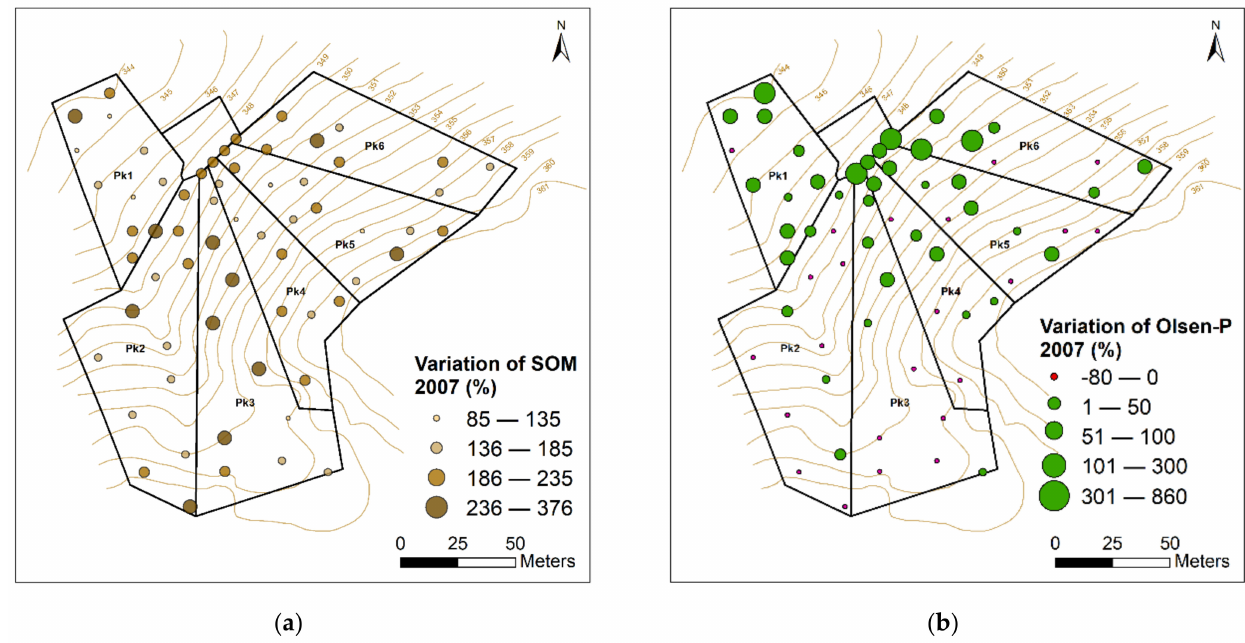
Figure 5. Spatial distribution of the variation (%) of ( a ) SOM and ( b ) Olsen-P (labile P) after two years from the beginning of the